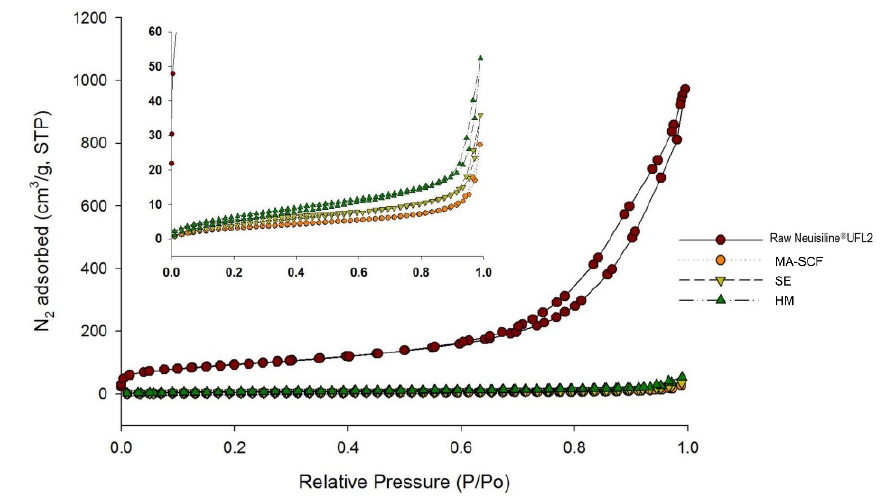
Figure 12. Nitrogen adsorption–desorption isotherms of raw Neusilin ® UFL2 and orlistat-loaded Neusilin ® UFL2 prepared by various amorphisation methods.